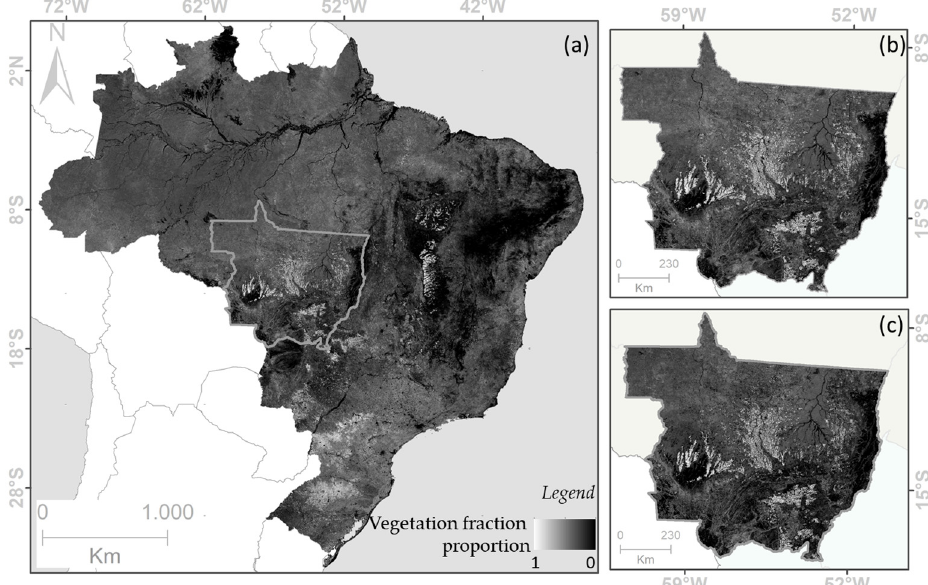
Figure 6. Maximum vegetation fraction mosaic derived from the linear spectral mixing model (LSMM) of PROBA-V mosaics datasets. ( a ) Brazil, PROBA-V 1 km mosaic; ( b ) Mato Grosso, PROBA-V 1 km mosaic; and ( c ) Mato Grosso, PROBA-V 100 m mosaic.